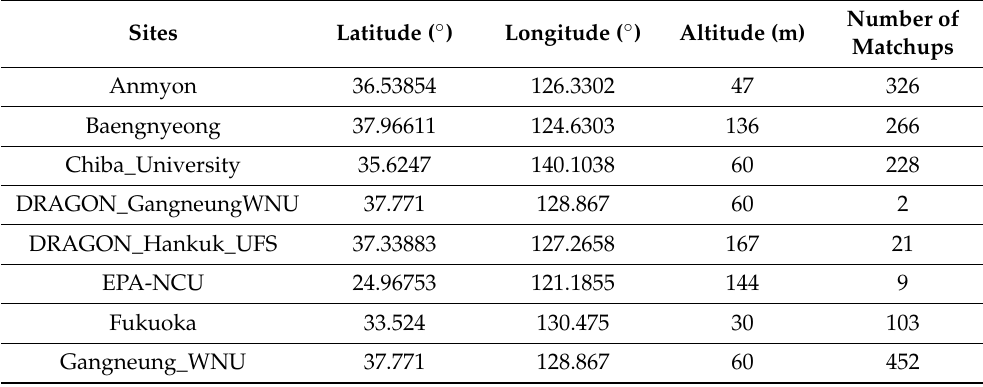
Table 2. List of AERONET sites used in this